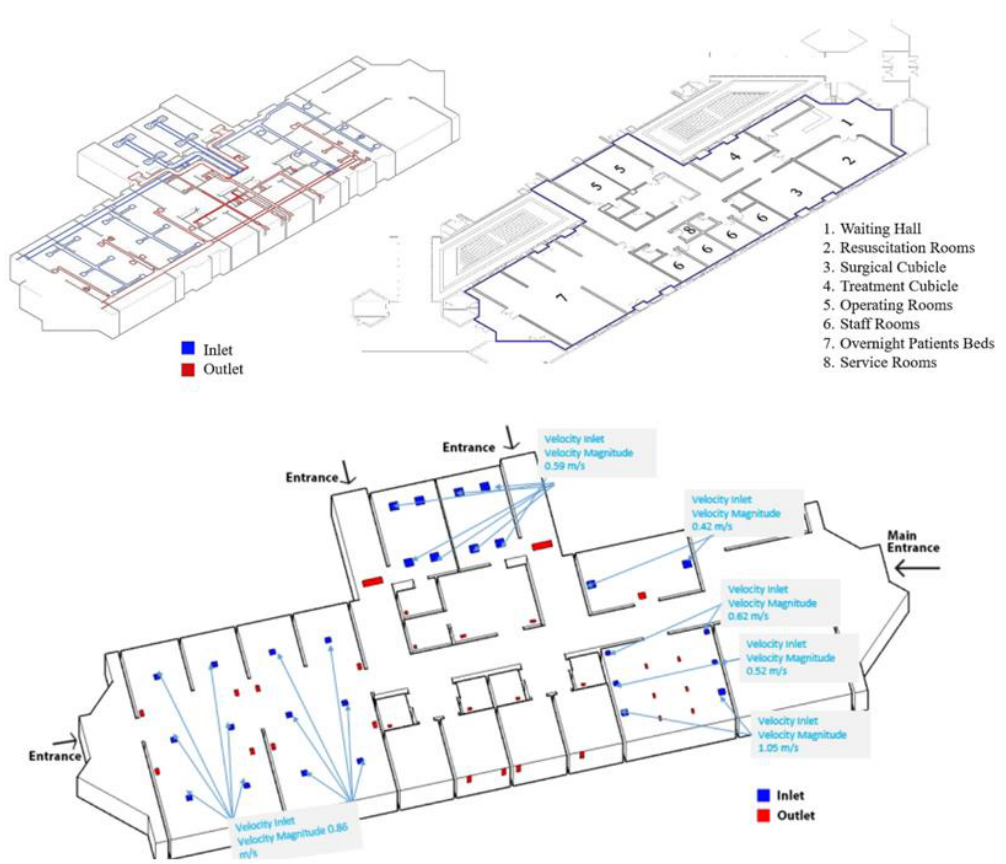
Figure 1. The geometry and specifications of the emergency department.